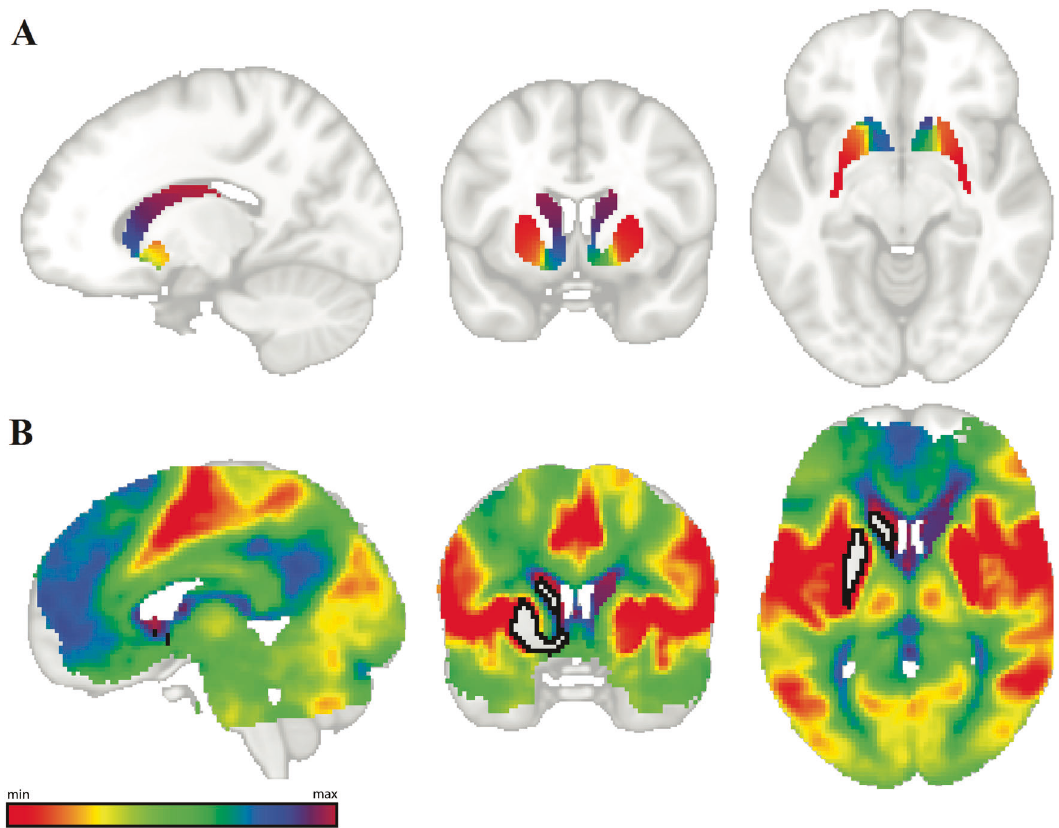
Fig. 2 Results of connectopic mapping. A average principal striatum gradient. B Average projection of left striatum gradient (black outline: left striatum), colors match those in A